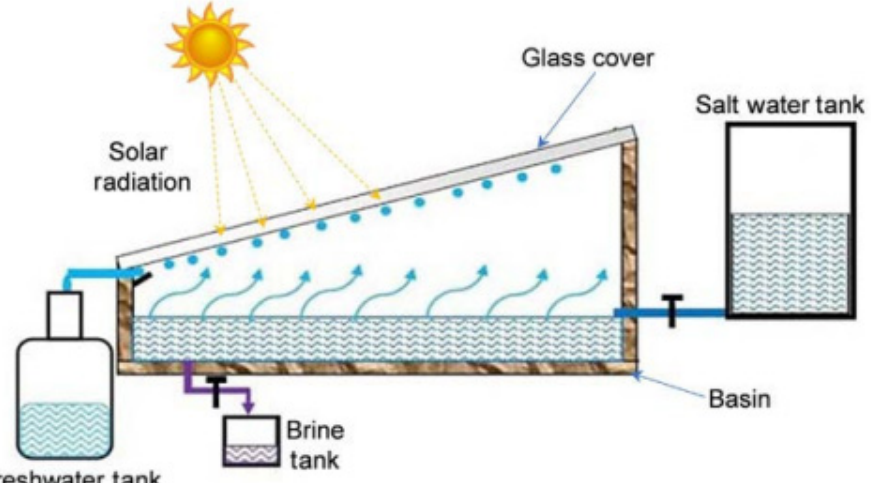
Figure 4. Principle of Earth-Water Collector (adapted with permission from Reference [28], Copyright 2015, Elsevier).